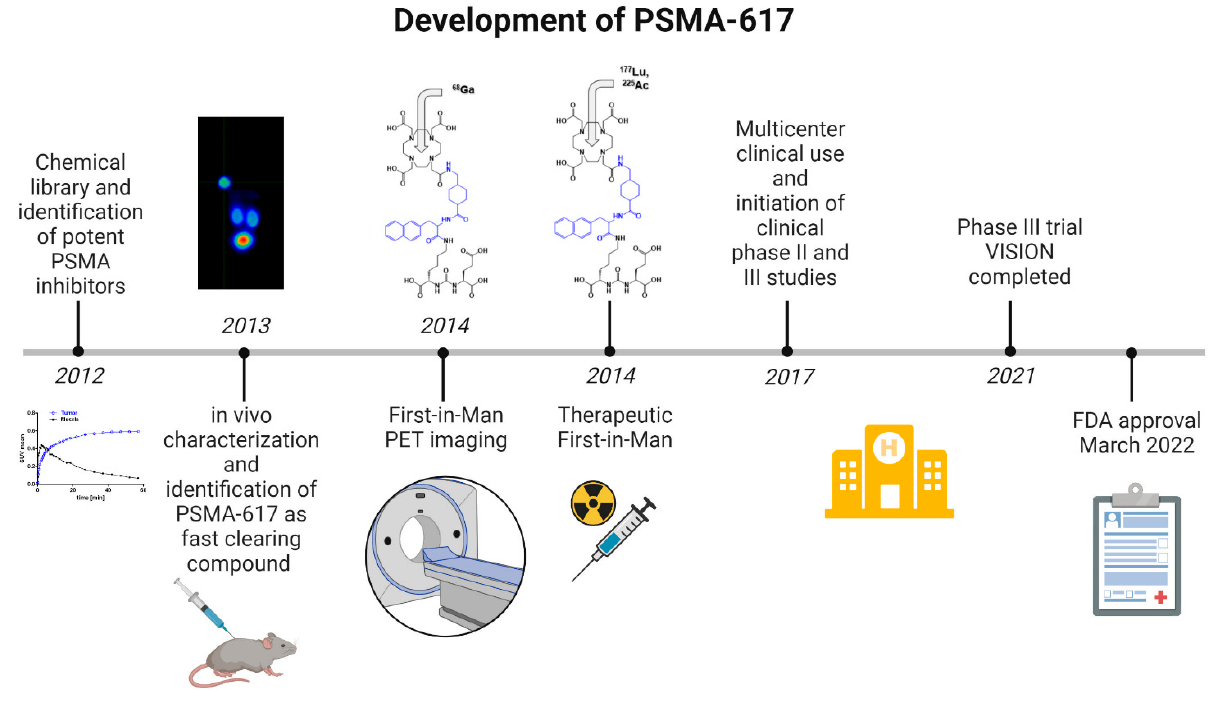
Figure 1. Development of PSMA-617.